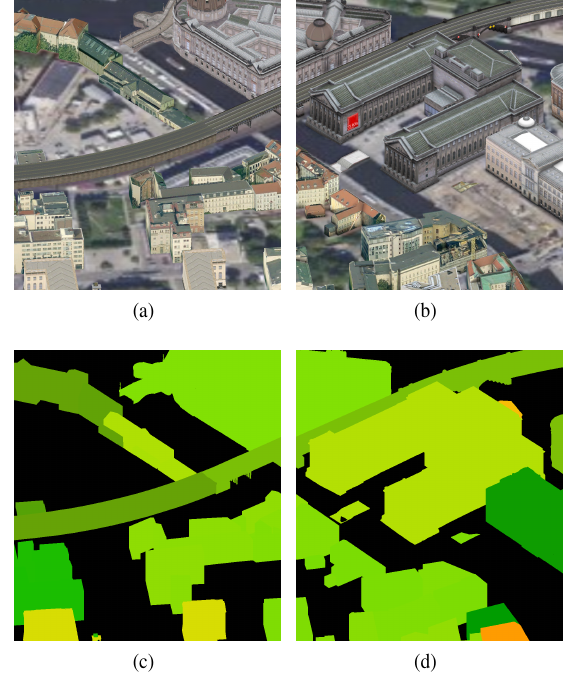
Figure 3: Examples for corresponding image tiles generated by the tileable color (subfigure a) and b) ) and corresponding ob- ject map images (subfigure c) and d). The object id images al- lows client applications to connect each pixel position of the color image to an underlying backend data object in order to connect client side visualization with backend